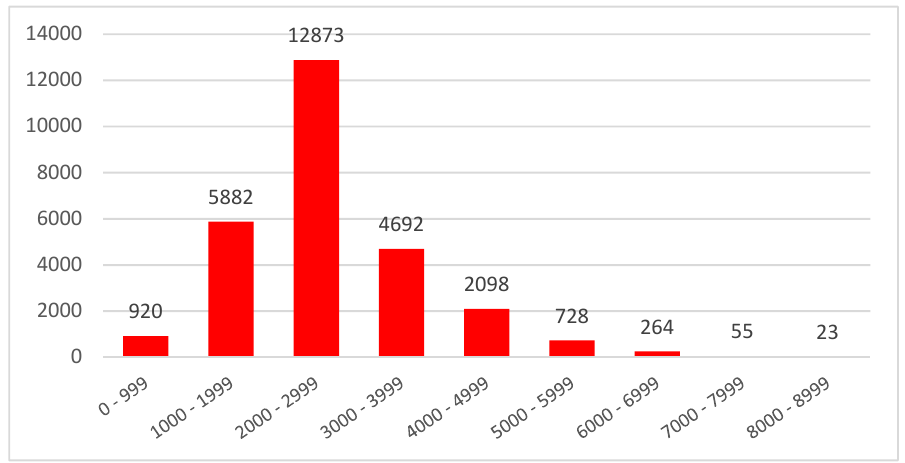
Figure 2. Length distribution of the transcripts after de novo assembly.